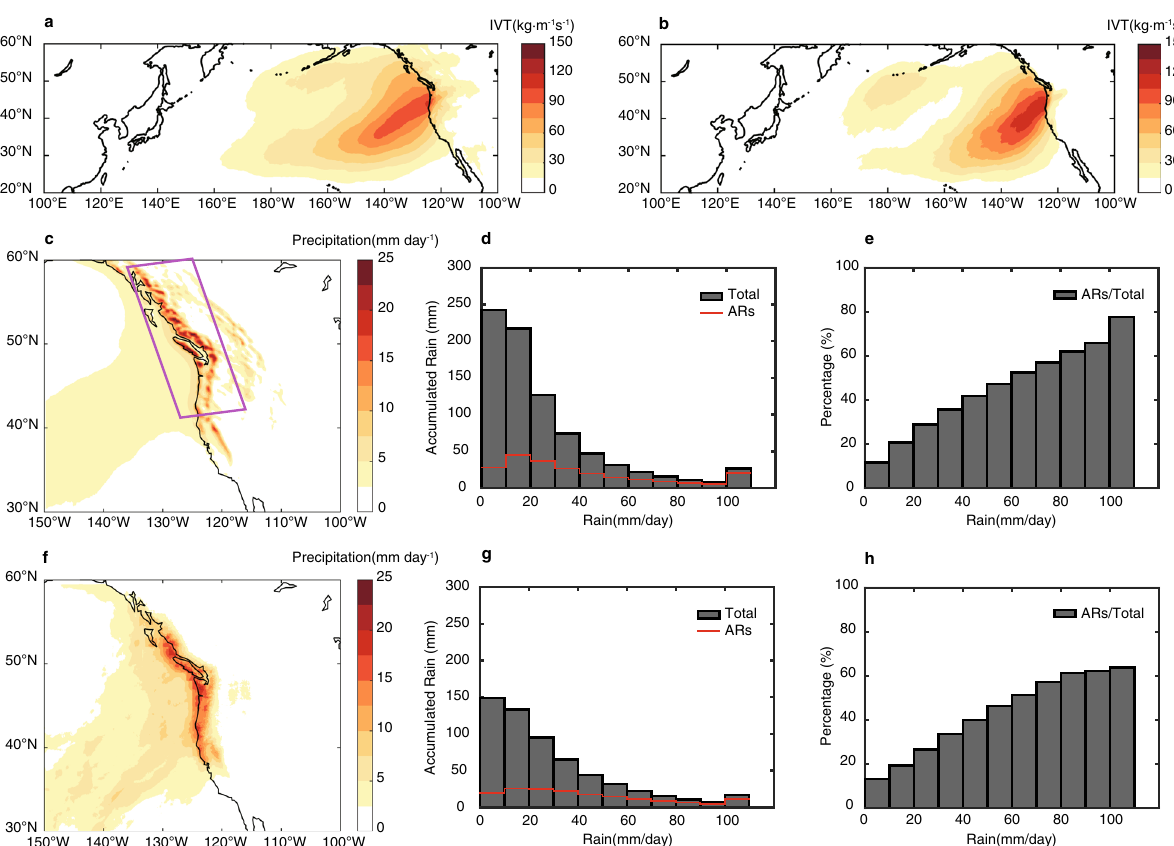
Fig. 1 Landfalling atmospheric rivers (ARs) and concurrent precipitation along the west coast of North America. Averaged integrated water vapor transport (IVT) associated with landfalling ARs simulated in seasonal-ensemble control (SE CTRL) ( a ) and in reanalysis data (ERA5, 1979-2017) ( b ) during the winter season (NDJFM). Averaged precipitation associated with landfalling ARs simulated in SE CTRL ( c ) and in satellite-based precipitation data (GPM, 2014-2016) ( f ) during the winter season (NDJFM). Probability density functions (PDFs) of daily precipitation (averaged in the magenta box in Fig. 1c) for total precipitation events (histogram) and those concurrent with landfalling ARs (red line) in SE CTRL ( d ) and in GPM ( g ), respectively. PDFs of fraction contribution (%) of AR-related precipitation to total precipitation in SE CTRL ( e ) and in GPM ( h ), respectively. Averaged IVT (precipitation) is computed as the sum of IVT (precipitation) associated with landfalling ARs divided by the total number of landfalling ARs